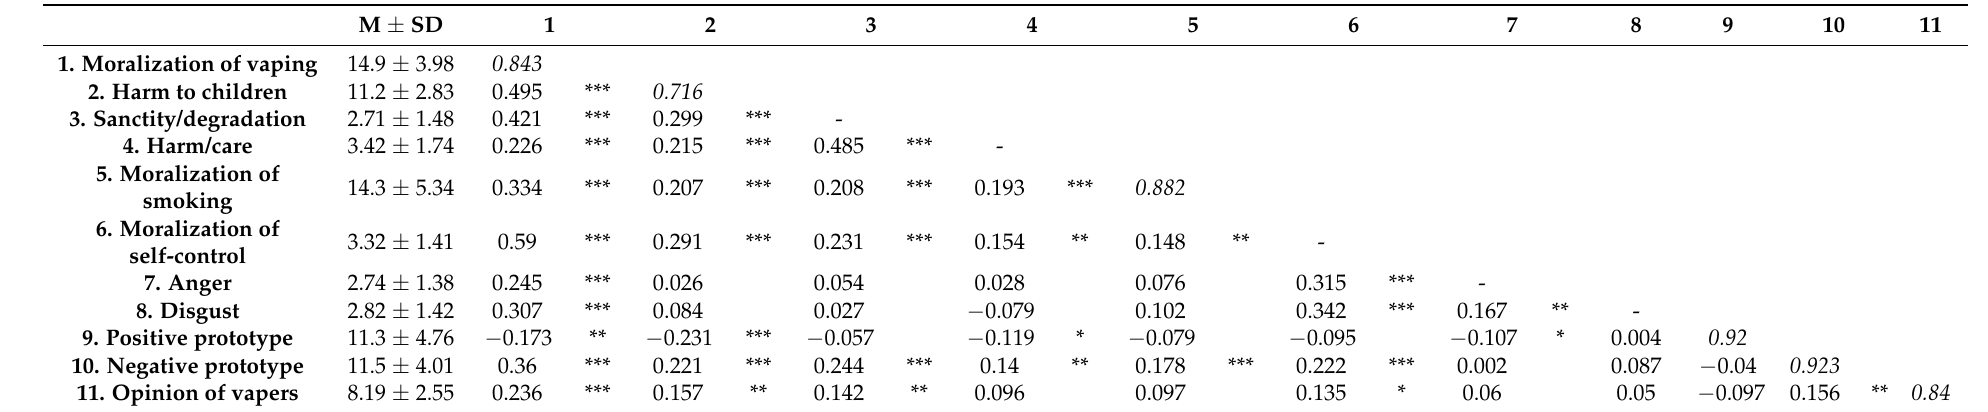
Table 1. Means, standard deviations, Cronbach’s α (on the diagonal), and Pearson’s r correlations between moralization of vaping and its